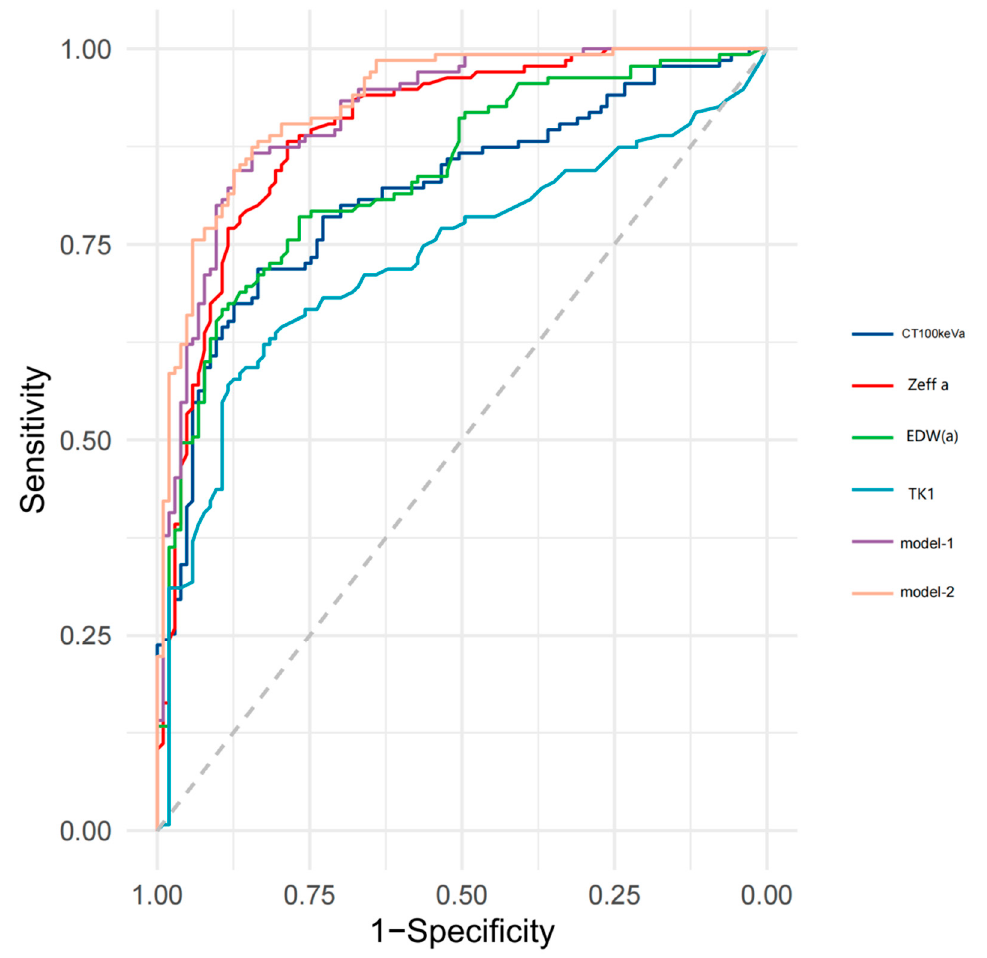
Figure 4. Comparison of the efficacy of the joint diagnostic models 1 and 2 with spectral dual-layer detector-based computed tomography (SDCT)-derived quantitative parameters. Zeff, effective atomic number; EDW, electron density; TK1, thymidine kinase-1; model-1, Zeff (a) + EDW (a) + CT100 keVa + Daverage; model-2, Zeff (a) + EDW (a) + CT100 keVa + Daverage + TK1; AP, arterial phase; VP, venous phase.